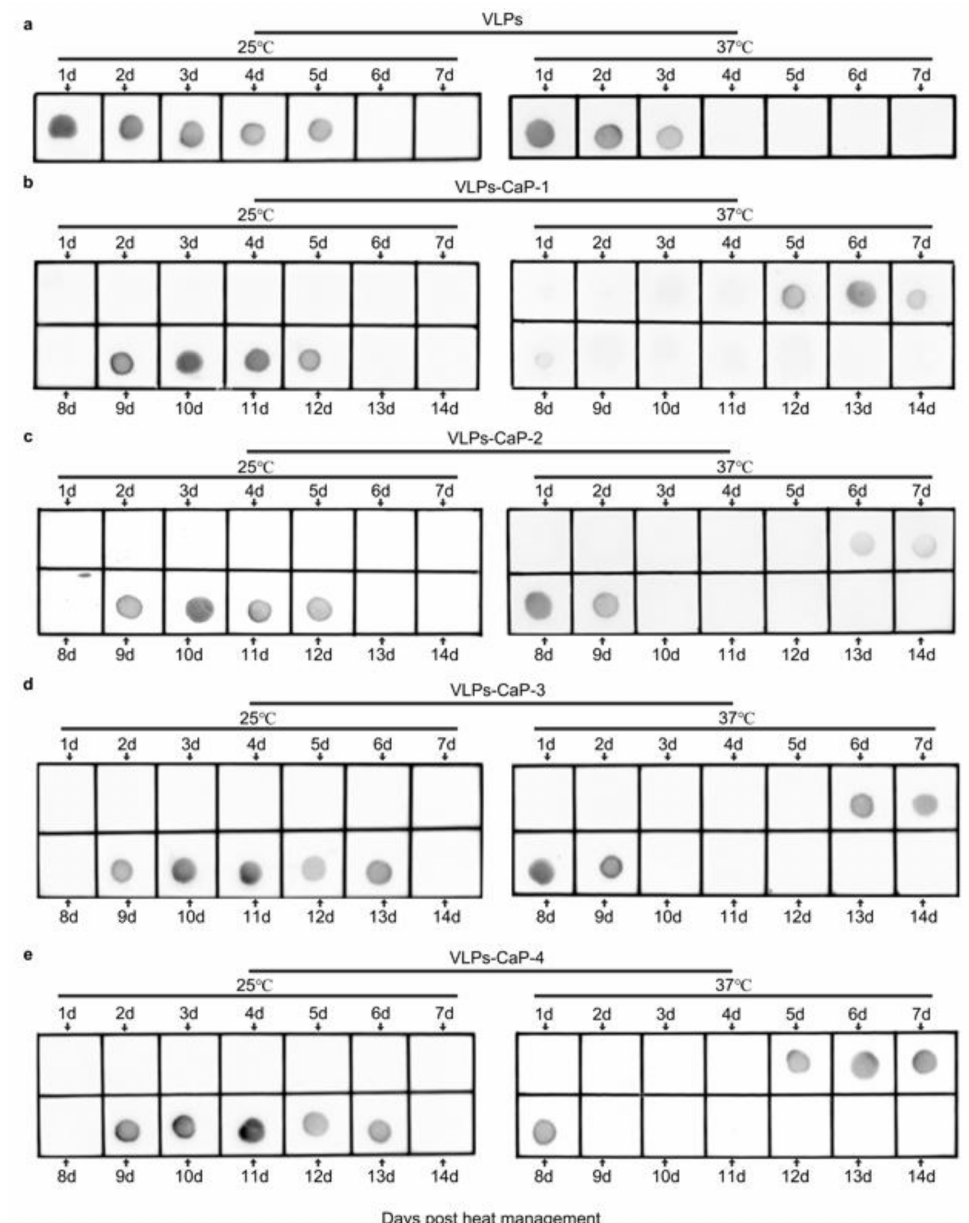
Figure 4. Thermo-resistance of the VLPs-CaP complexes. At 25 ◦ C and 37 ◦ C, VLPs were left for 1–7 days and VLPs-CaP for 1–14 days. VLPs in the supernatants of ( a ) VLPs, ( b ) VLPs-CaP-1, ( c ) VLPs-CaP-2, ( d ) VLPs-CaP-3, and ( e ) VLPs-CaP-4 were detected by dot blot